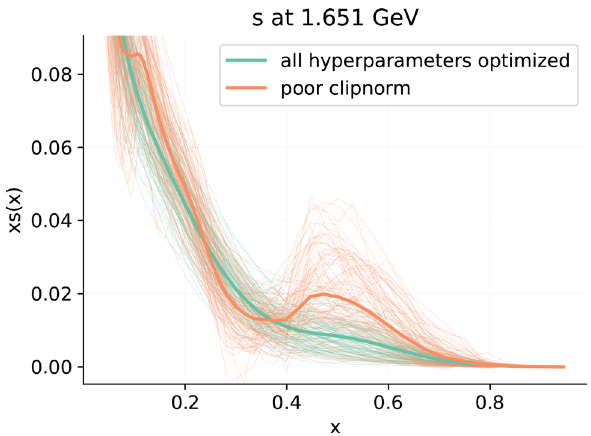
Fig. 9 Comparison between the results for the strange PDF and large x in two fits, one with all hyperparameters optimized and another where the clipnorm one is not